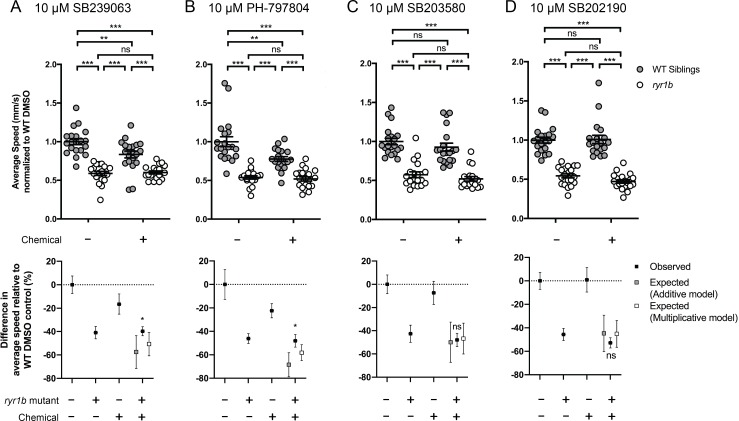
Positive chemical-genetic interactions between p38 inhibitors and ryr1b mutants were observed using zebrafish larval movement speed as a readout.Compared to the average speed of DMSO WT controls, treatment with (A) SB239063 and (B) PH-797804 reduced the average speed of WT siblings while the expected decrease in movement speed in treated ryr1b was not observed. The difference in average speed of ryr1b+p38 inhibitor compared to WT controls (i.e. WT siblings+DMSO vehicle) is higher than expected given the effects of genotype and chemical alone, indicative of a positive chemical-genetic interaction. Chemical-genetic interactions were not observed for p38 inhibitors (C) SB203580 and (D) SB202190. Data are presented as mean ± SEM movement speed (mm/s) normalized to DMSO-treated WT siblings for n = 2 independent experiments. Statistical analysis by two-way ANOVA followed by Tukey’s multiple comparisons post-test. *p<0.05, **p<0.01, ***p<0.001; Sample size n = 19 or 20 for each treatment group in a set.